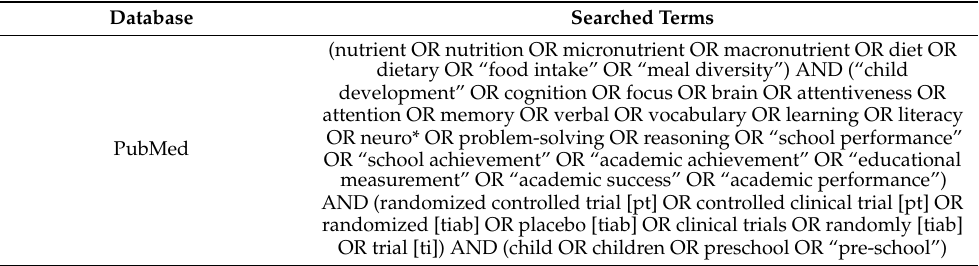
Table A2. Search Strategy used for each electronic